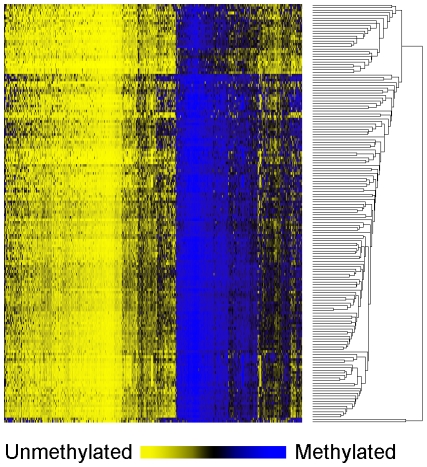
Unsupervised clustering heatmap of CpG methylation in breast carcinomas.Unsupervised hierarchical clustering heat map based on Manhattan distance and average linkage of the 750 autosomal CpG loci with the highest variance. Samples are in rows (n = 162), and CpG loci are in columns. Blue indicates methylated and yellow indicates unmethylated.